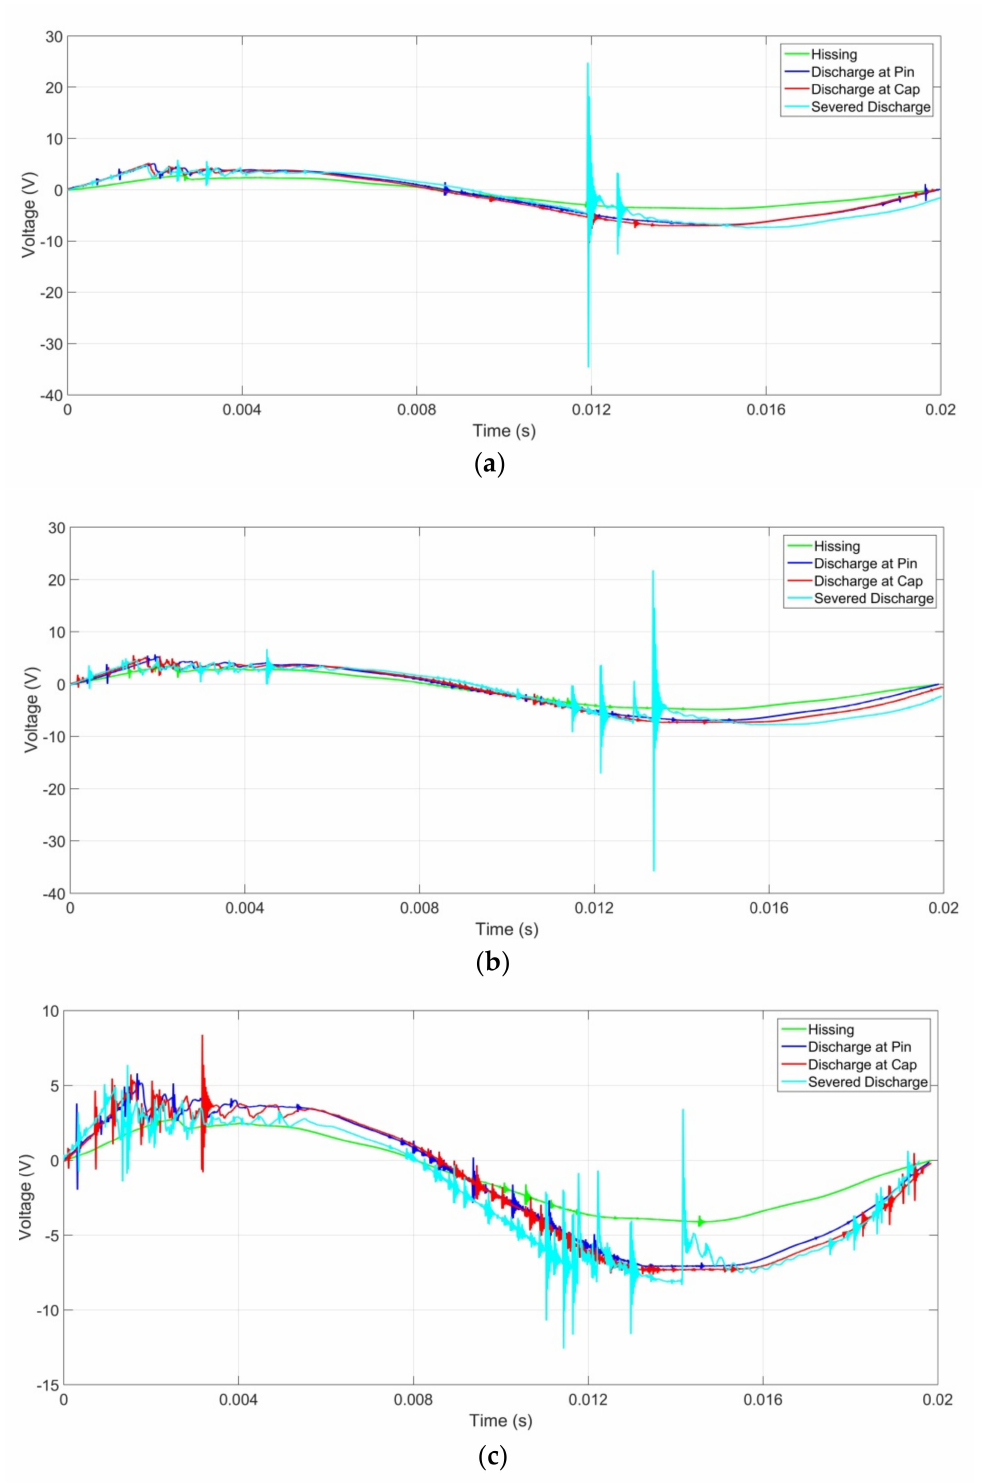
Figure 8. UV signal for insulator samples at heavy contamination level with insulator ages